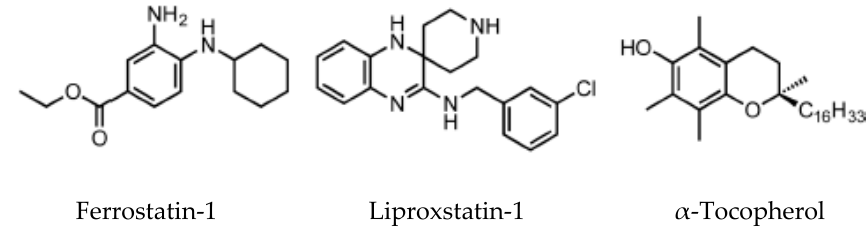
Figure 4. Ferroptosis inhibitors [52] .